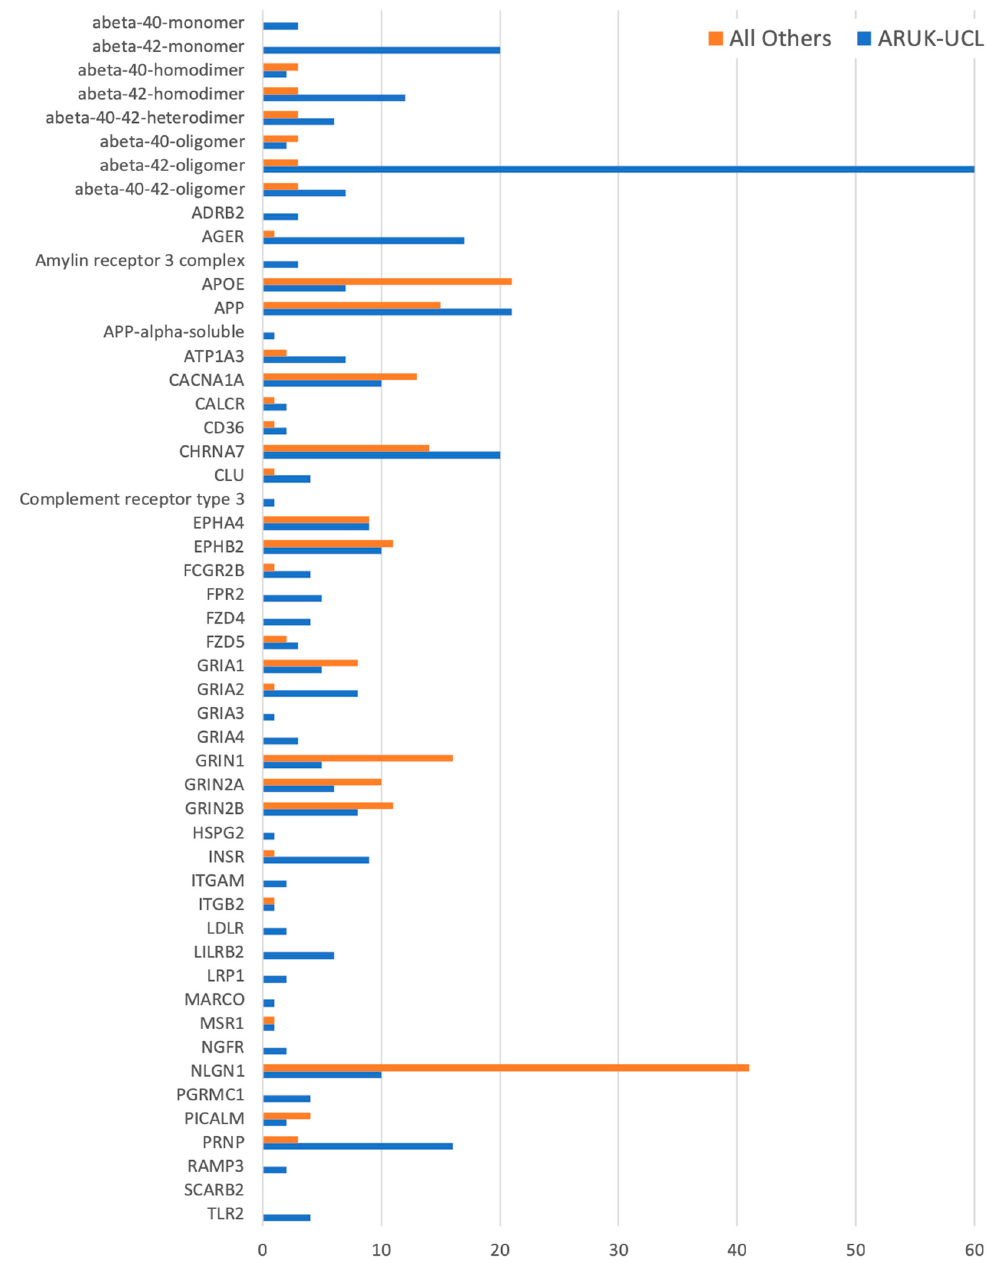
Figure 2. A histogram of all of the manually curated neurological GO annotations for the prioritised amyloid-beta-relevant human gene products, including annotations contributed by ARUK-UCL as well as by other groups. Data for this figure was derived from Table S5.